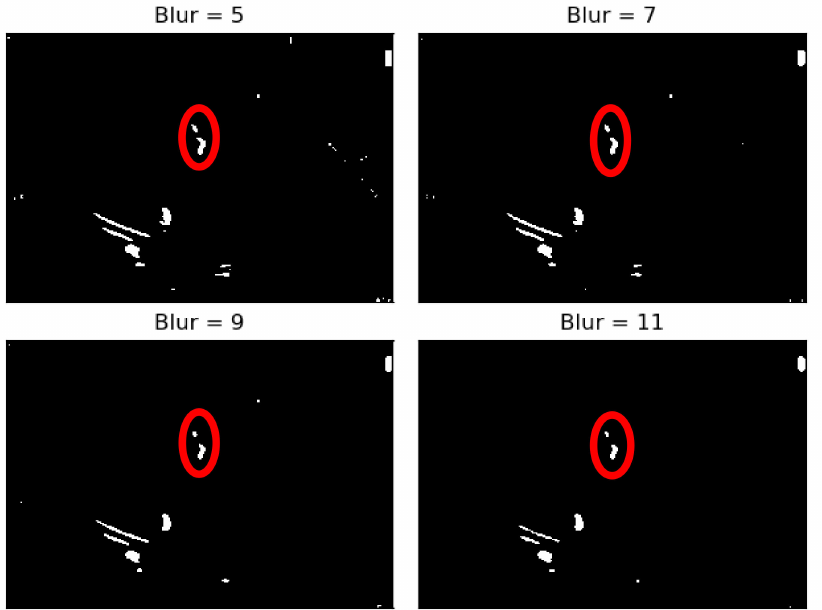
Figure 5. Binarization of an echocardiography image, for each size of the kernel parameter applied— The red circle represents our ROI (aortic valve).